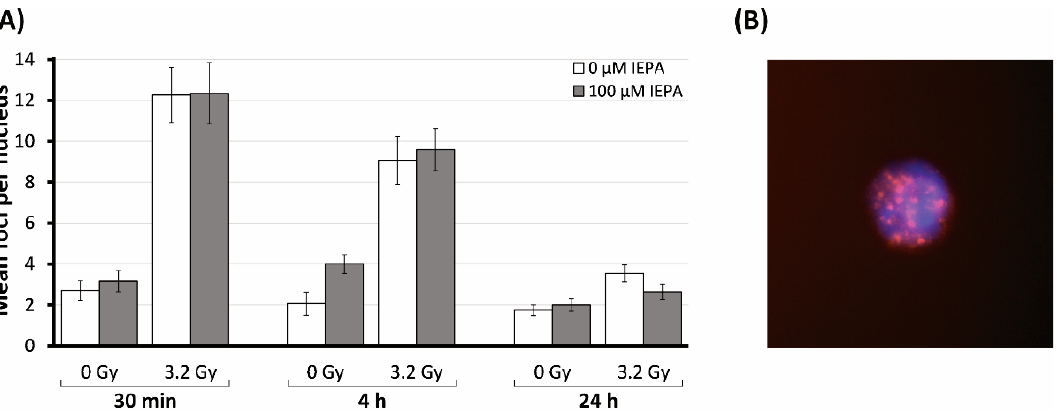
Figure 8. ( A ) Number of γ H2AX foci in CD34 + HSPCs irradiated (3.2 Gy) and treated with IEPA (100 µM) over the course of 24 h compared with sham-irradiated control. Foci scored in 30 cells per group are presented as mean value ± SEM/nucleus. ( B ) Example of CD34 + HSPC in DAPI staining (blue) with IR-induced γ H2AX foci (red); original magnification: ×100.